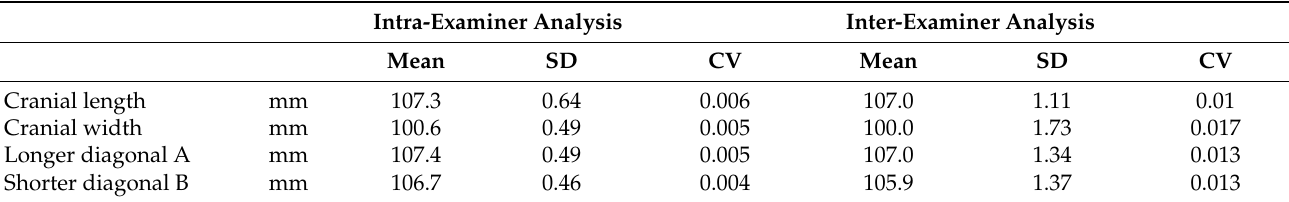
Table 1. Evaluation of inspection accuracy using a dummy doll.